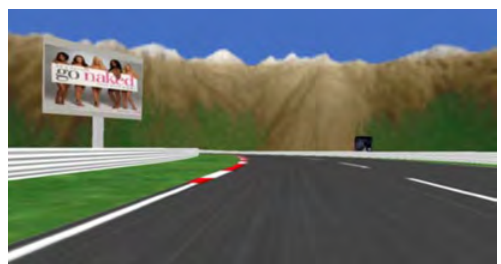
Figure 3. Typical scene from the curved race track with billboards.